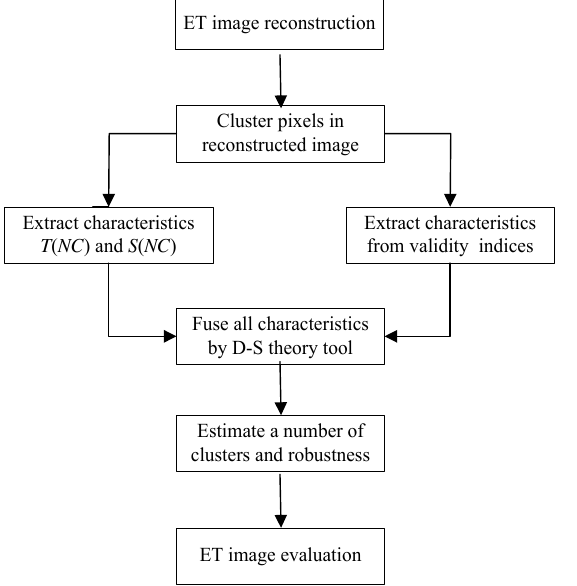
Fig.1 . Flowchart of the evaluation processes of the new proposed validity indices for the reconstructed images.